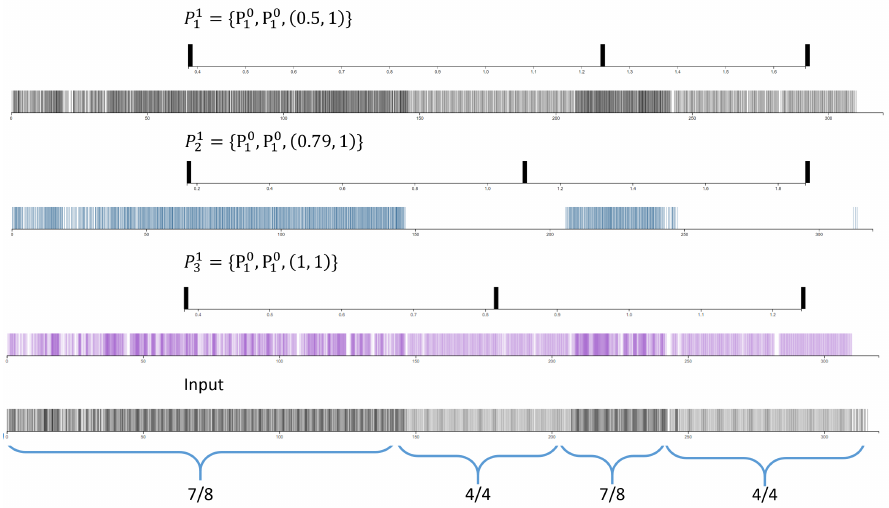
Figure 16. The three parts forming the L 1 layer for the Severina’s song. All activations for the parts P 1 and P 1 are shown in violet and blue colors respectively. It may be clearly observed that the P 1 2 covers the input song segments played in 7/8 meter, while P 1 meters segments.